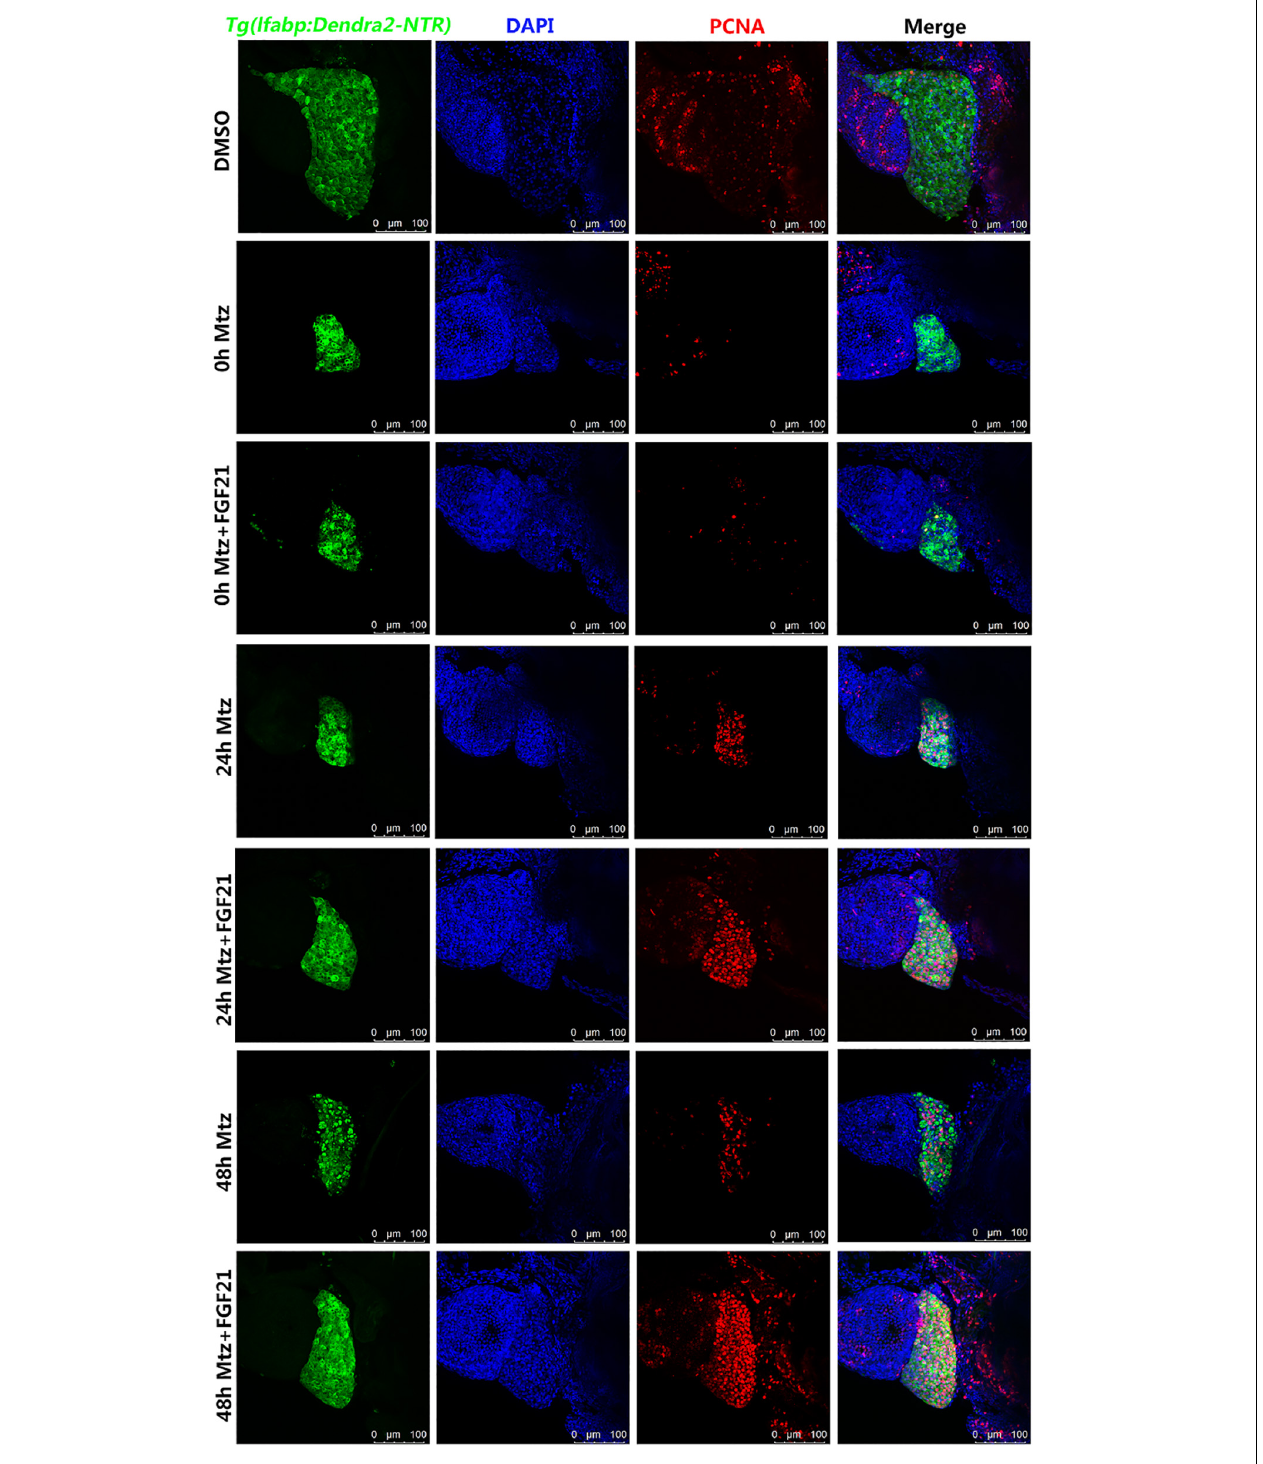
FIGURE 4 | Fibroblast growth factor 21 accelerates liver cell regeneration after injury. Samples were collected at 0, 24, and 48 hpa to assess the production of new cells in the damaged liver. PCNA assay performed to assess the level of the formation of new cells in the damaged liver. Liver cells (green fluorescent Denra-NTR), stromal cells (blue fluorescent DAPI), and PCNA positive cells (red fluorescent). DMSO group: without Mtz treatment, DMSO was applied. Mtz group: after Mtz treatment, grow naturally. Mtz+FGF21 group: after Mtz treatment, treated with FGF21 standard protein ( n = 40 per group, repeat 3 times for each test). Scale bar = 100 µ